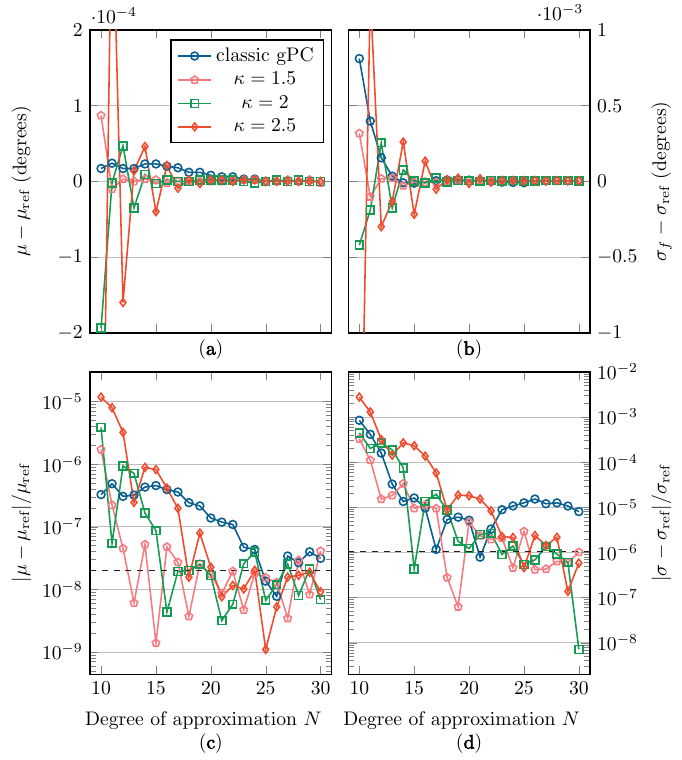
Figure 12. The absolute and relative errors on µ ( a , c ) and σ ( b , d ) with regard to their reference value when applying the Beta ( x ;3,3 ) distribution. The precision floor is shown by a dashed line. In Figure 13, a comparison between the resulting classic and mapped gPC approx- imations of f , using the Beta ( x ; 2, 2 ) distribution and N = 15, is shown. In Figure 14, the comparison of the resulting empirical cumulative distribution functions (CDFs) is plotted.